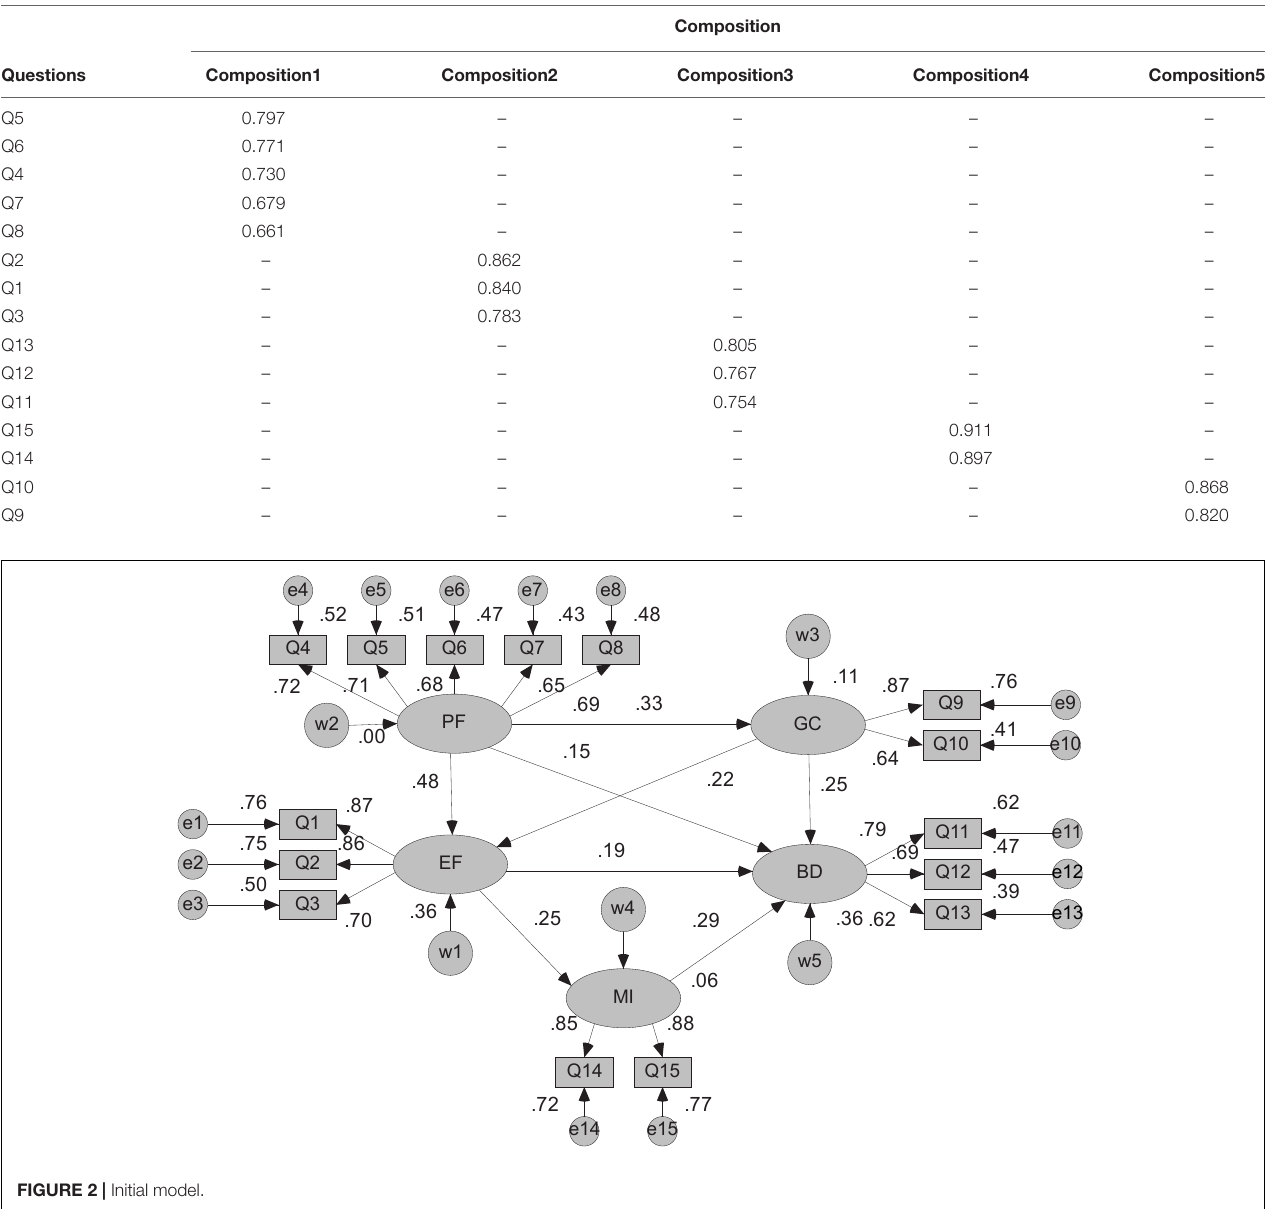
FIGURE 2 | Initial